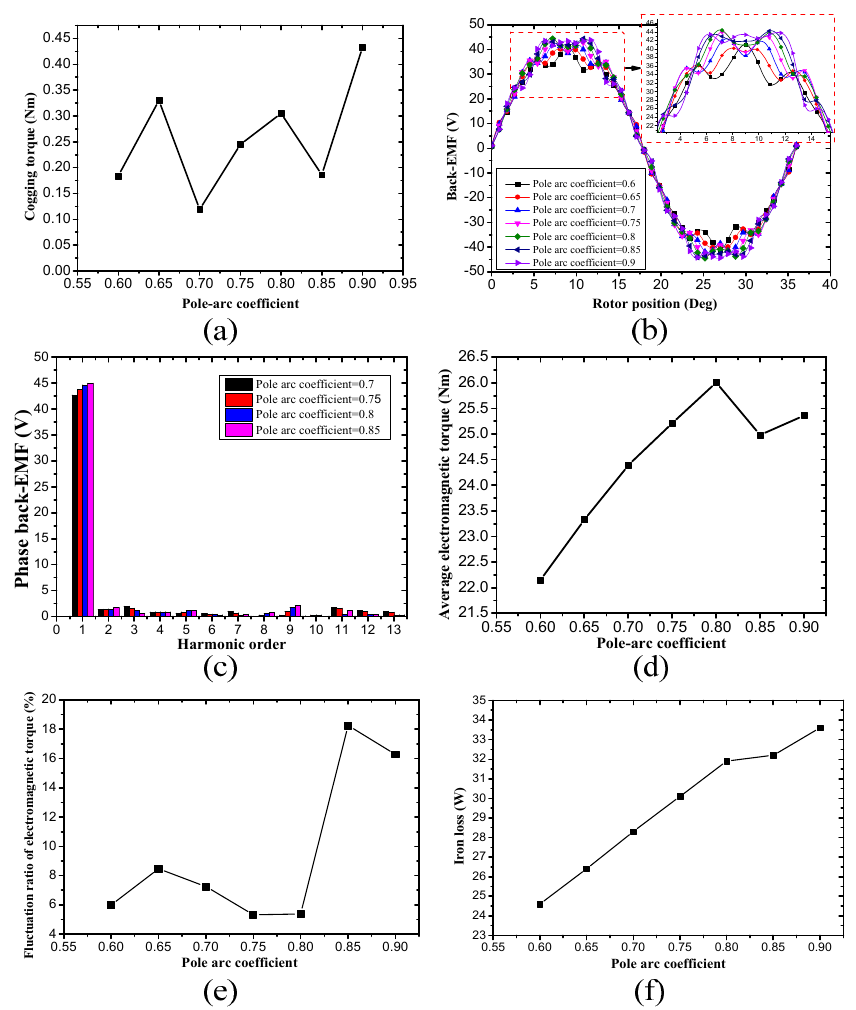
Figure 15. Influence of the pole arc coefficient ( a ) Cogging torque ( b ) Back-EMF ( c ) Harmonic analysis of the phase back EMF ( d ) Average electromagnetic torque ( e ) Fluctuation ratio of electromagnetic torque ( f ) Iron loss.